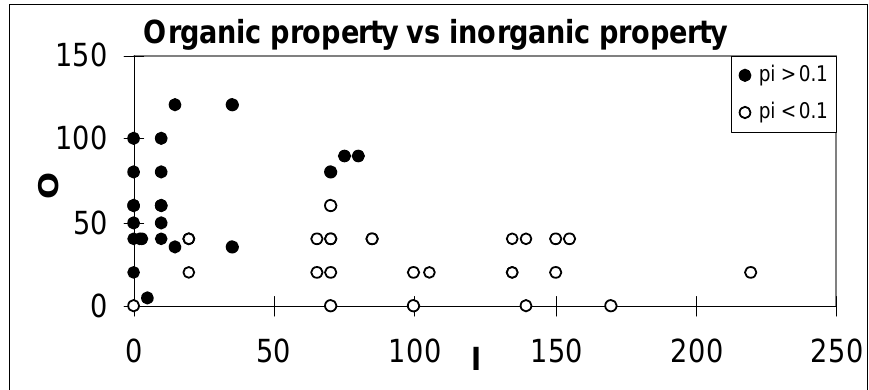
Figure 1. Organic property value versus inorganic property value of 50 common